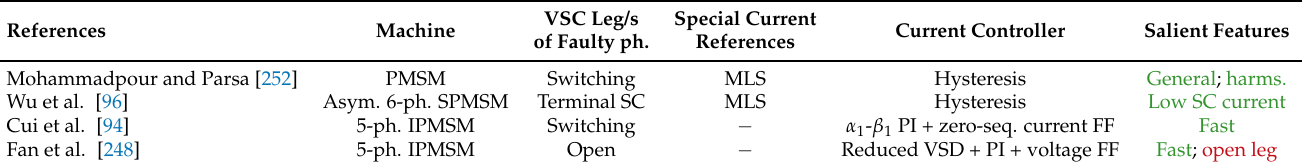
Table 15. Current control methods for reducing torque ripple under turn SCs (Section 5.3.3.4) in multiphase applications in the